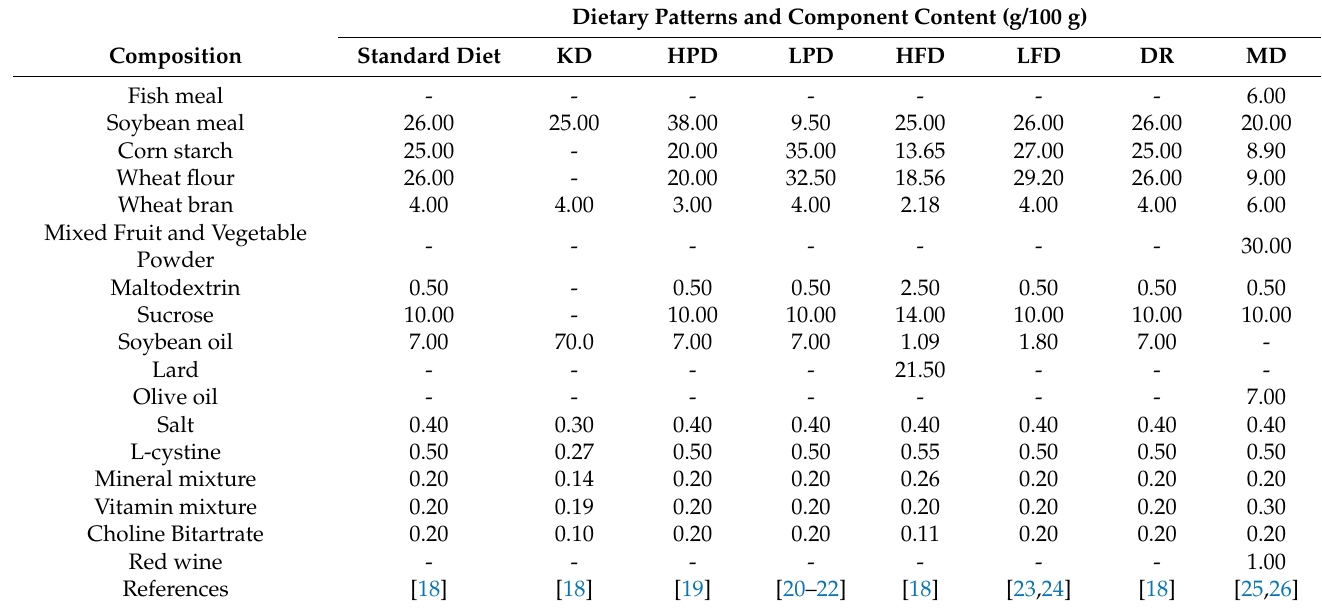
Table 1. Different dietary patterns and component content of mice tumor models. Dietary Patterns and Component Content (g/100